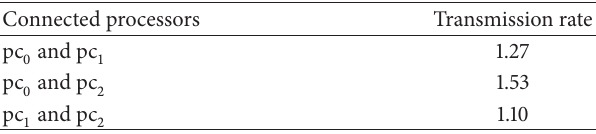
Table 2: Transmission rate between different processors.